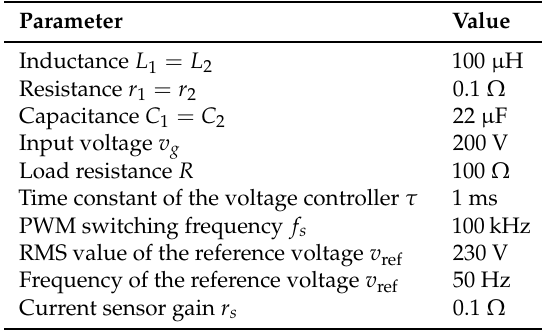
Table 1. The used parameters for the DC-AC differential boost